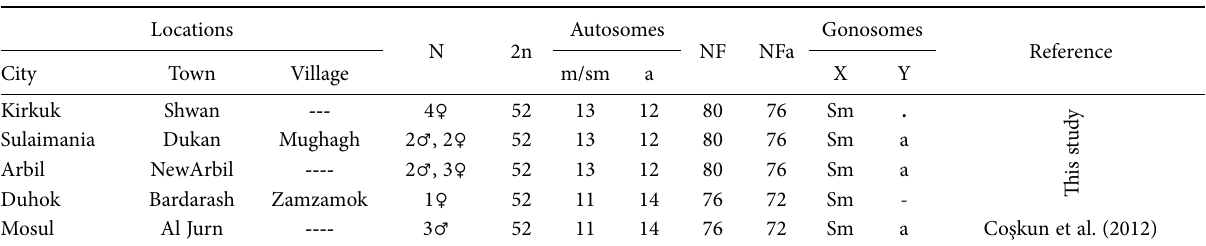
Table 1. The localities of samples that chromosomal analysis was performed in Iraq ( N: sample size, 2n: diploid chromosome numbers,